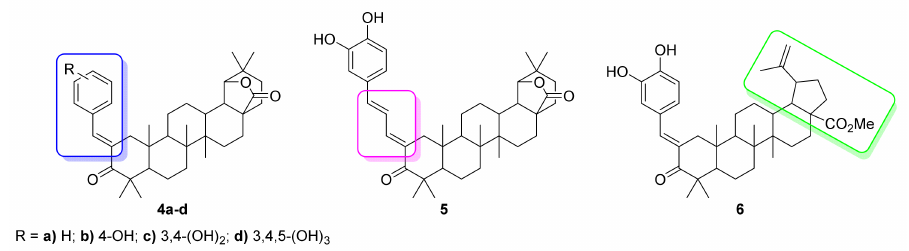
Figure 2. Chemical structures of the target